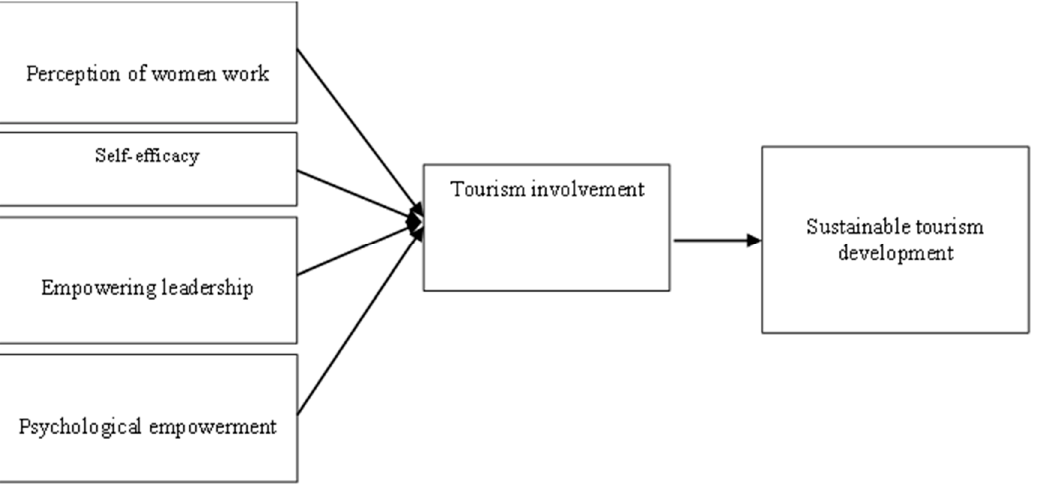
Figure 1 . The proposed research